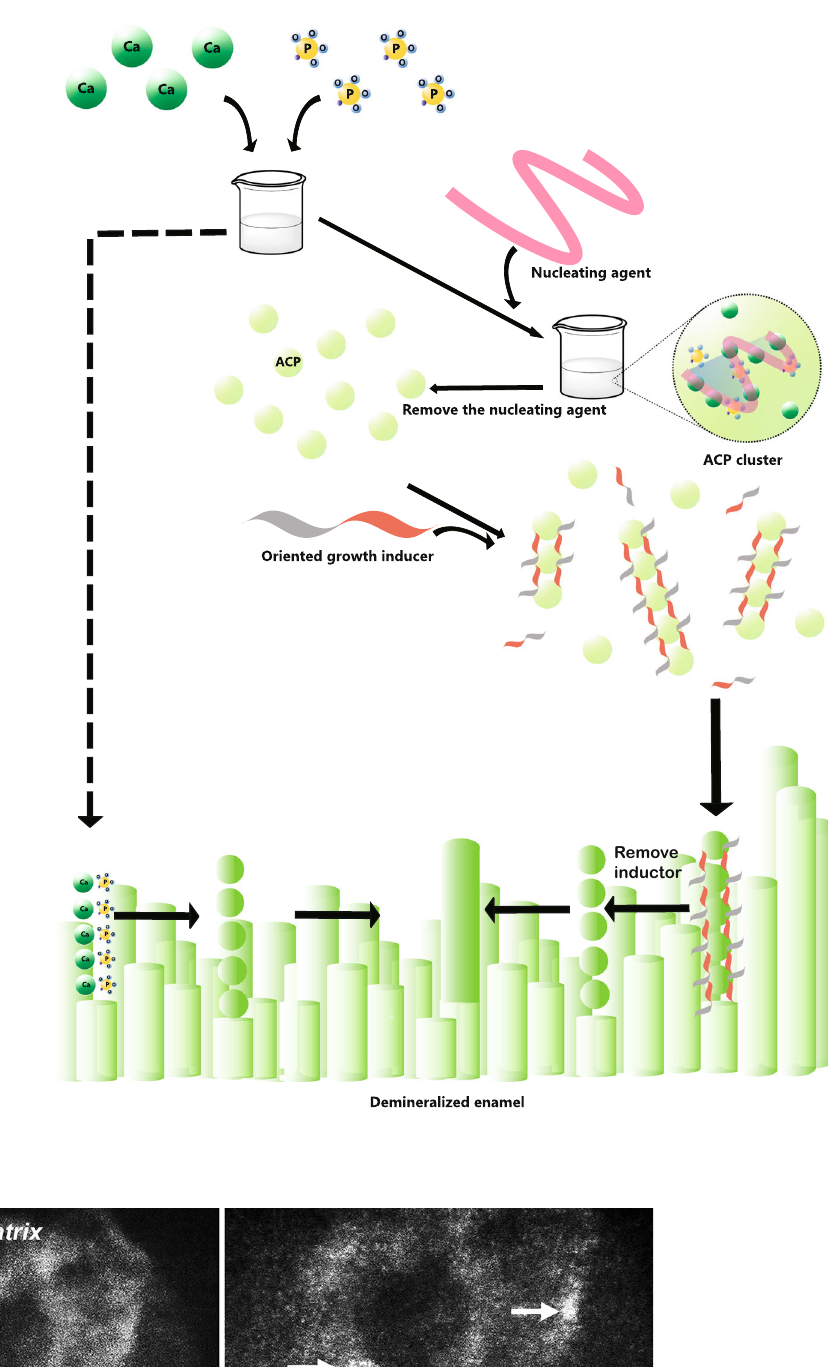
Fig. 1 A schematic model of the formation of ACP and transform into enamel-like crystals for biomineralisation. Strategy A (solid arrow): CaP will be stabilised by nucleating agent and form into ACP clusters. After the removement of the agent, the ACP will transform into crystals. Strategy B (dashed arrow): fl ow of CaP are selected or accelerated into the deep lesions, then nucleate to form ACP and fi nally transform into